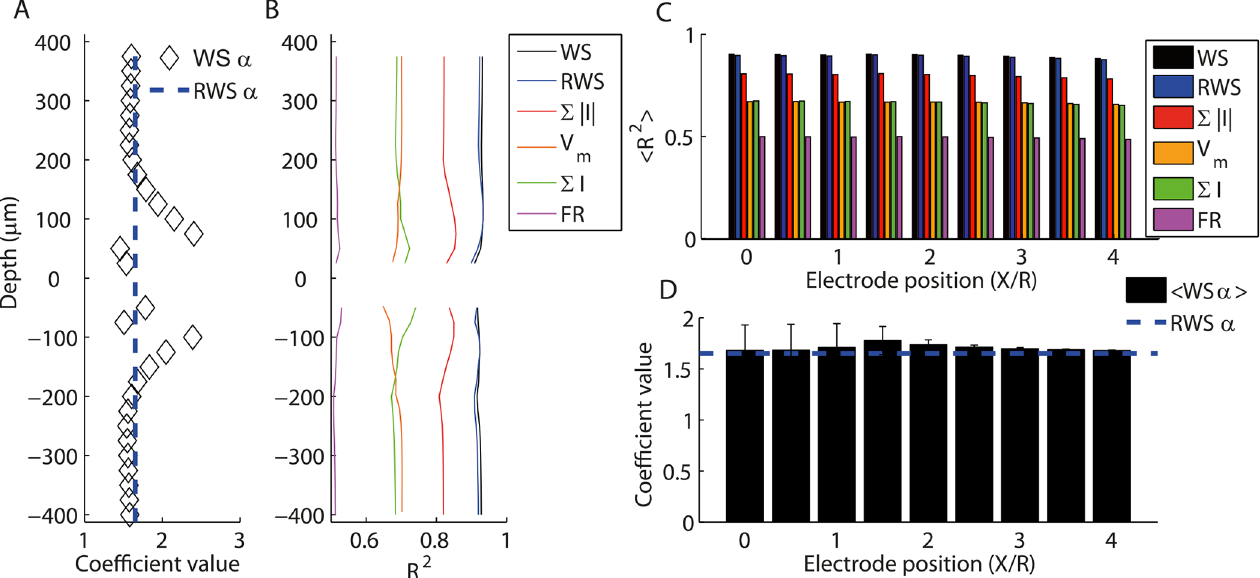
Fig 5. New proxy explaining more than 90% of the variance in the LFP signal. (A) Value of relative contribution of AMPA and GABA currents ( α parameter in Eq (3)) optimizing correlation between WS proxy and ground truth LFP in the same conditions as Fig 4. Dashed line indicates average value over depths α = 1.65 used for RWS proxy (Eq 4). (B) Same as Fig 4F and 4G including also WS proxy (black) and RWS proxy (blue). (C) Fraction of LFP variance explained, averaged over all depths, by different proxies for different distances from the center of the 3D network. From best to worst: weighted sum (WS), reference weighted sum (RWS), sum of absolute values of the synaptic currents ( ∑ | I |), membrane potential (V m ), sum of synaptic currents ( ∑ I ), firing rate (FR). Error bars are not displayed since they would not be visible in the figure. (D) Mean and standard deviation across depths of optimal coefficients of α in the WS proxy as a function of electrode lateral position. Dashed line indicates the fixed coefficient of the RWS proxy that was not optimized but kept constant for all depths and distances.